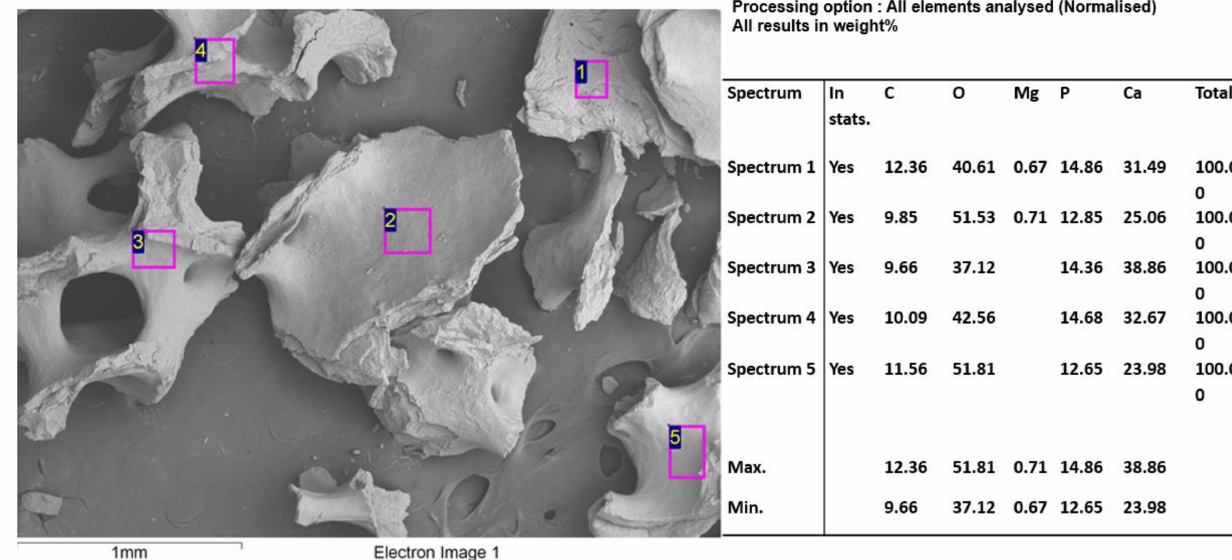
Figure 7. F1 (InterOss) SEM/EDS analysis.